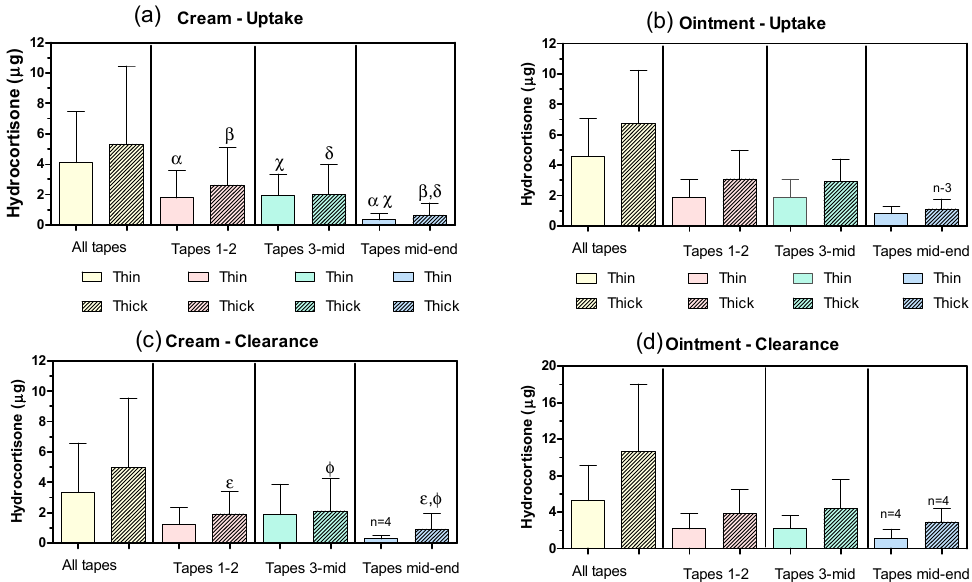
Figure 3. Mean ( ± SD, n = 5 except indicated otherwise) hydrocortisone (HC) recovery for ( a ) uptake-cream; ( b ) uptake-ointment; ( c ) clearance-cream and ( d ) clearance-ointment samples following thin (empty bars) and thick (hatched bar) application. All tapes (yellow bars); T 1–2 (pink bars); T 3-mid (green bars) and T mid-end (blue bars). The results from eight ANOVAs used to assess differences in HC across three sections of the stratum corneum (SC) are shown; the pairs of values which are significantly different ( p < 0.02) are identified by the matching Greek symbols ( α , β , χ , δ , ε and φ ). Note the different Y-axis range used for the ointment-clearance data set.